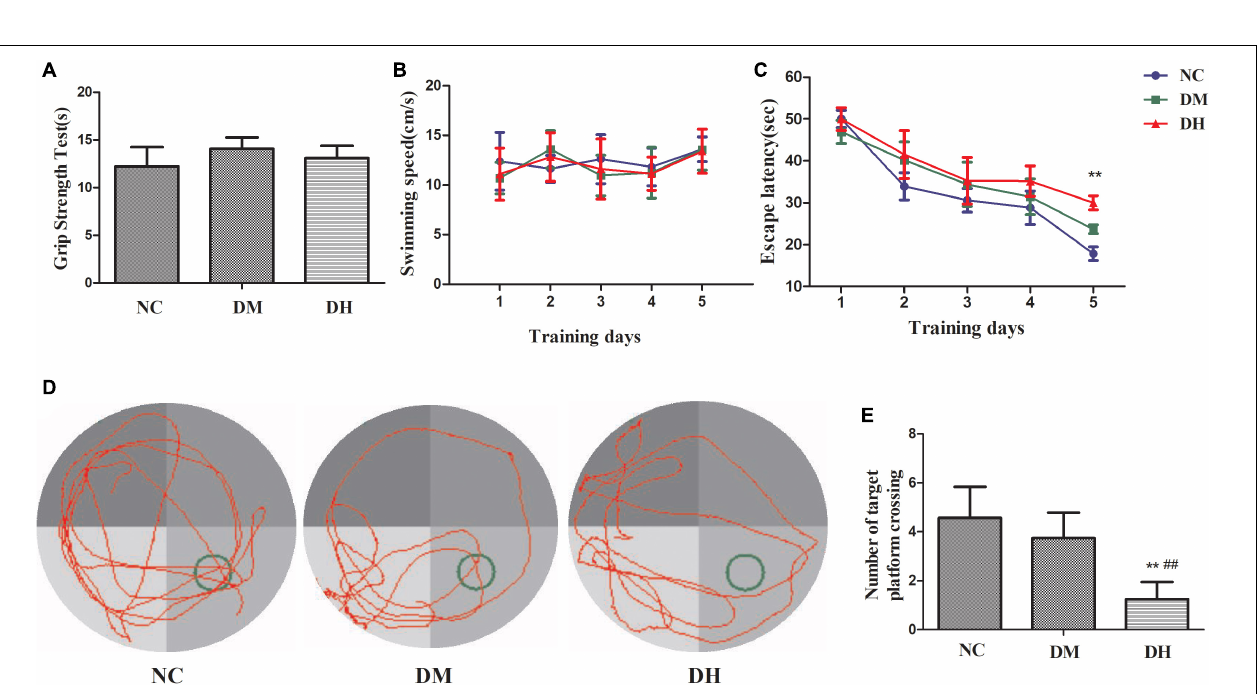
FIGURE 8 | Severe hypoglycemia caused cognitive dysfunction. (A) Sensorimotor testing by grip strength test. (B) Escape latency. (C) Swimming speed. (D) Representative traces of swimming paths of each group in the probe test. (E) Crossings of the target quadrant during the probe trial. N = 10 per group. Data are the means ± SEM. ** P < 0.01 NC vs. DH, ## P < 0.01 DM vs. DH.